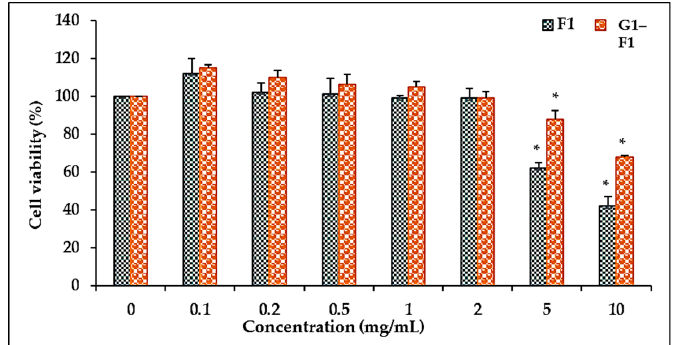
Figure 3. Cytotoxicity of ginsenoside F1 and α -glycosylated ginsenoside F1 in human dermal fibroblast cells. Cells were preincubated with or without compounds for 24 h, and cell viability was evaluated by 3-(4,5-dimethylthiazol-2-yl)-2,5-diphenyltetrazolium bromide (MTT) assay. Data represent the mean ± SD (standard deviation) of triplicate experiments. * p < 0.05 compared with the control. F1: ginsenoside F1; G1–F1: α -glycosylated ginsenoside F1.